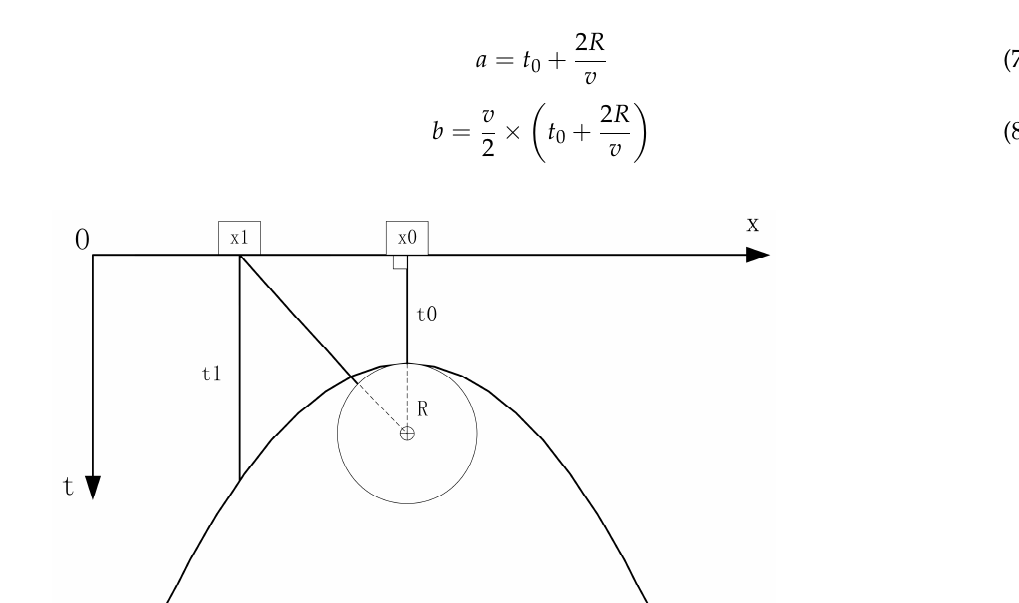
Figure 10. The geometric model for root detection by GPR.